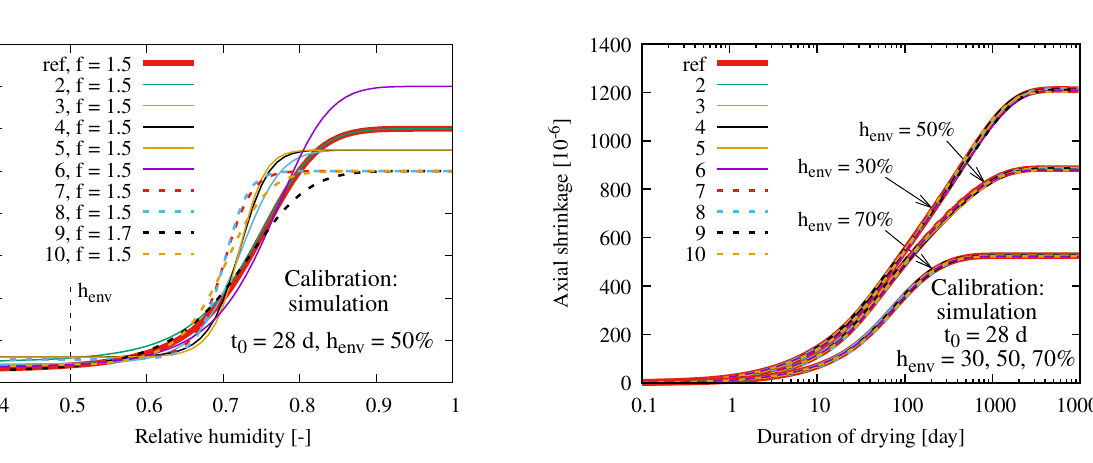
Figure 6. Best fits of (reference) axial shrinkage caused by symmetric drying at three levels of ambient relative humidity h env = 30 , 50 , 70% ( D = 150 mm, t 0 = 28 days).